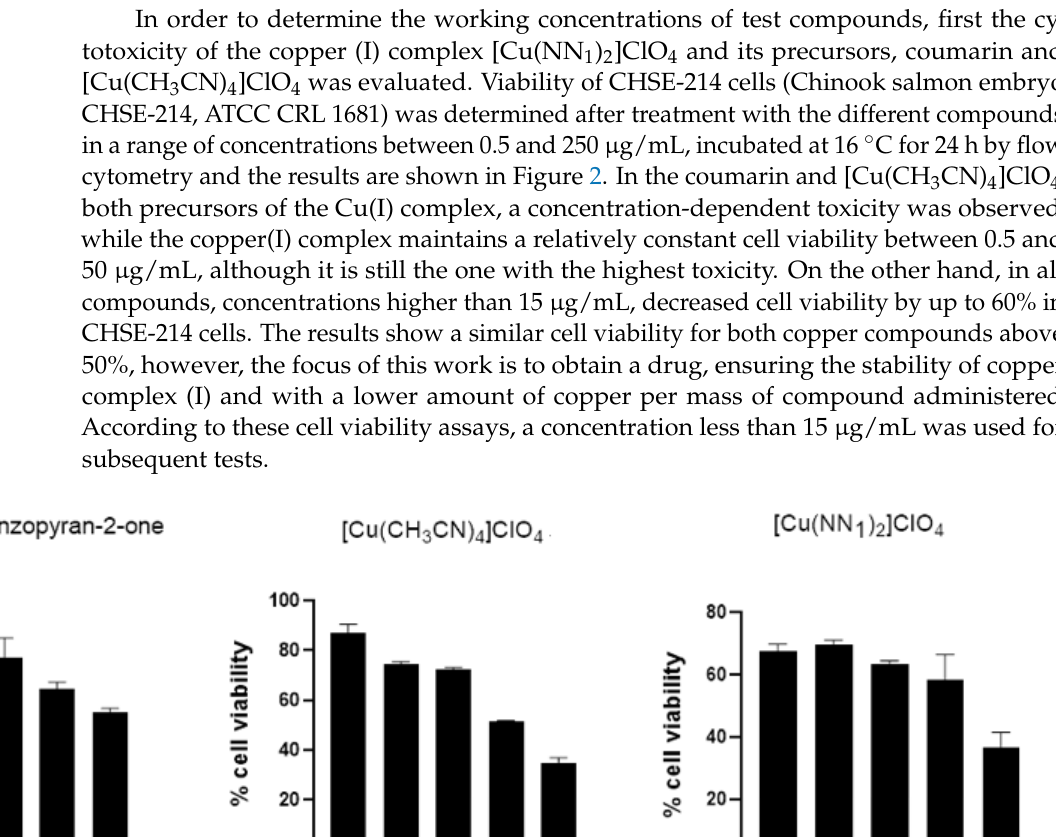
Figure 1. Chemistry Structure of Copper (I) Complex [Cu(NN 1 ) 2 ]ClO 4 . Where NN 1 is 6-((quinolin-